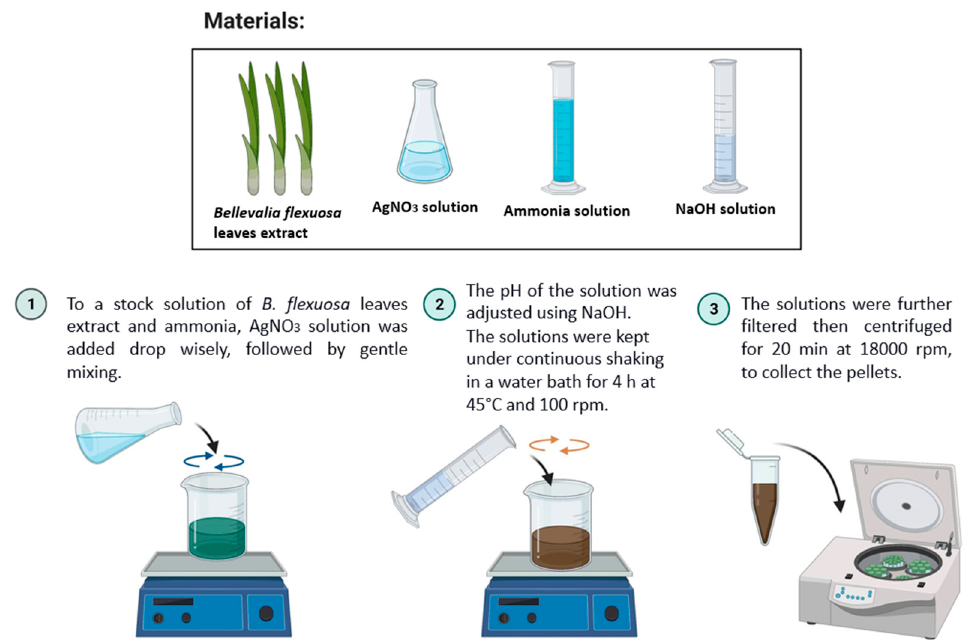
Figure 1. Scheme of the general method used in this work to synthesize green AgNPs. The materials used were B. flexuosa leaves extract and AgNO 3 , ammonia and NaOH solutions: 1. AgNO 3 solution was added, dropwise, to a stock solution of B. flexuosa leaves extract and ammonia, followed by gentle mixing; 2. The pH of the solution was adjusted, using NaOH. The solutions were kept under continuous shaking in a water bath for 4 h at 45 °C and 100 rpm; 3. The solutions were further filtered, then centrifuged for 20 min at 18,000 rpm.